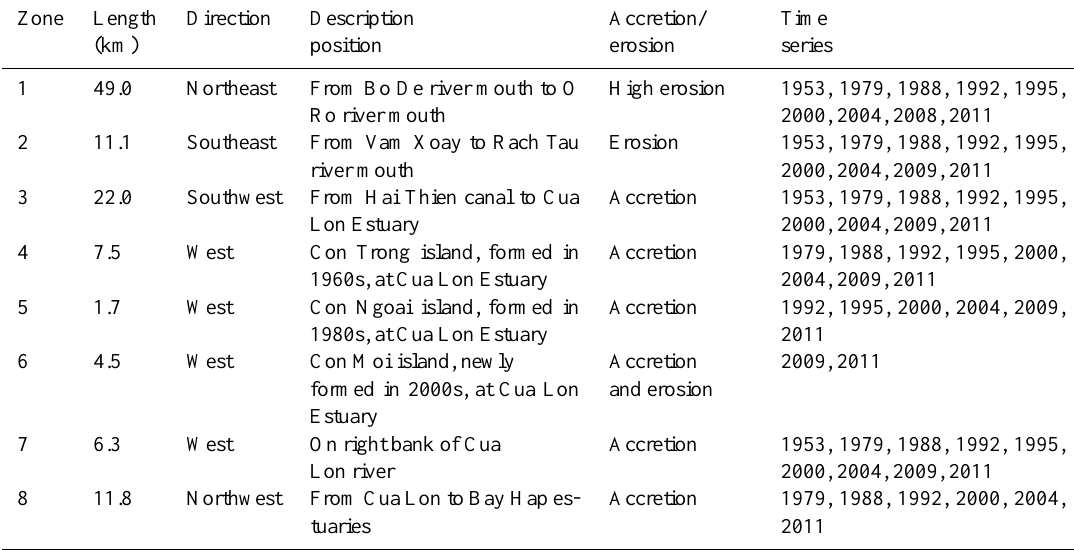
Table 2. Eight zones in the study area divided basing on coastal characteristics and availability of remotely sensed data. Zone